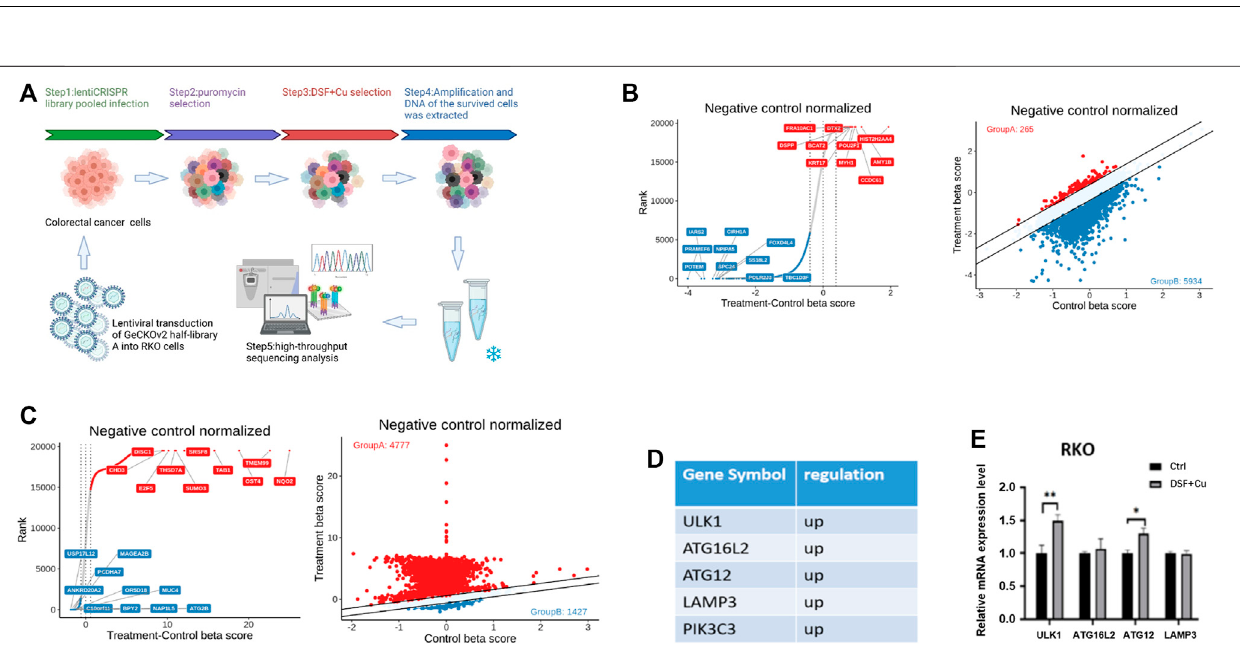
FIGURE 3 | DSF/Cu inhibits CRC cell viability by inducing autophagy as revealed by CRISPR-Cas9 library screening. (A) Schematic diagram illustrating the work fl ow for genome-wide CRISPR-Cas9 knockout library screening (CRISPR: Clustered Regularly Interspaced Short Palindromic Repeats). (B,C) The distribution displayofbetavalueofdifferentgenesinday0groupandDSFtreatmentgroupfor7 (B) or14 (C) days.Redpointsrepresentpositivescreeninggenes,andtheblueones are negative screening genes, (D) The positive screening genes related to autophagy. (E) qRT-PCR veri fi ed the expression of the upregulation autophagy-related genes in the control group and DSF/Cu. * p < .05; ** p < .01; *** p < .001.